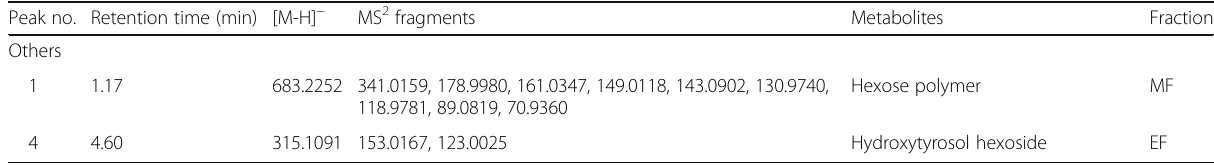
Table 2 Identification of phenolic constituents in bioactive fractions of N. oleracea based on UHPLC – MS/MS data (Continued) Peak no. Retention time (min) [M-H]